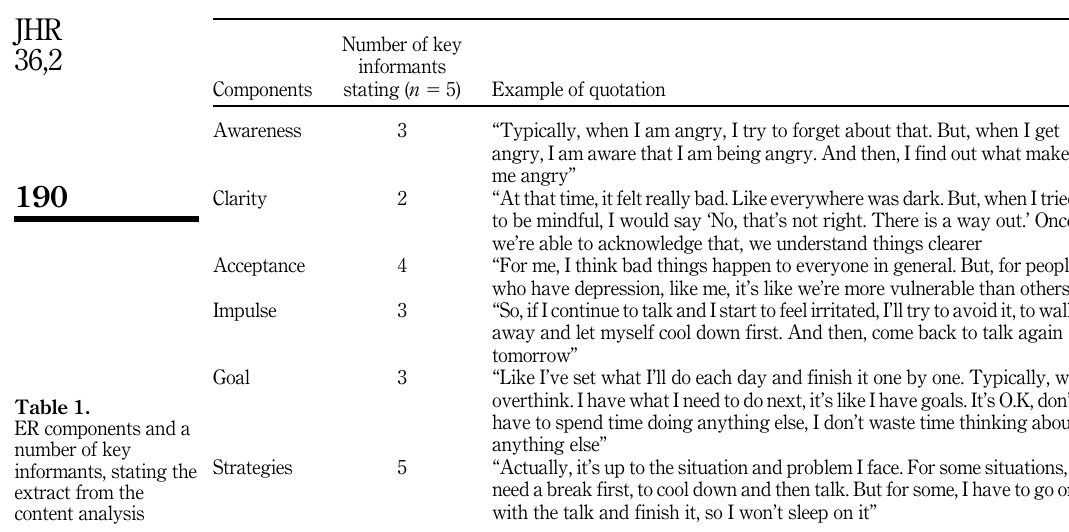
number of key informants, stating